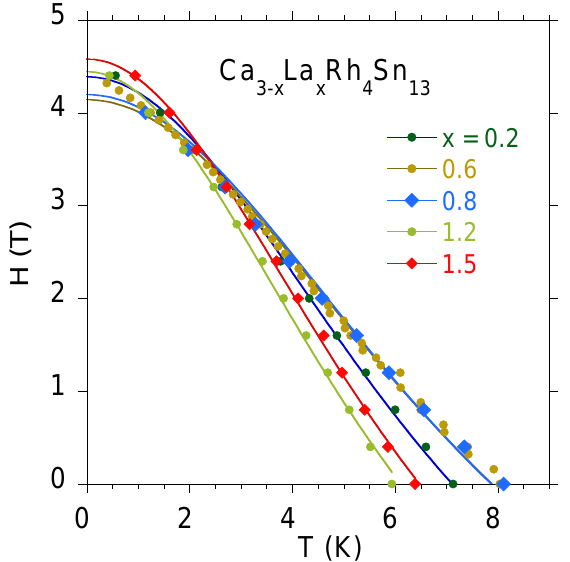
Figure 7. Temperature dependence of the upper critical field for doped La 3 Rh 4 Sn 13 . Note the negative correlation between H c 2 ( T = 0 ) and T c ( H = 0 ) . The continuous lines show the best fit of Ginzburg–Landau theory to experimental data, H c 2 ( T ) = H c 2 ( 0 ) 1 − t 2 1 + t 2